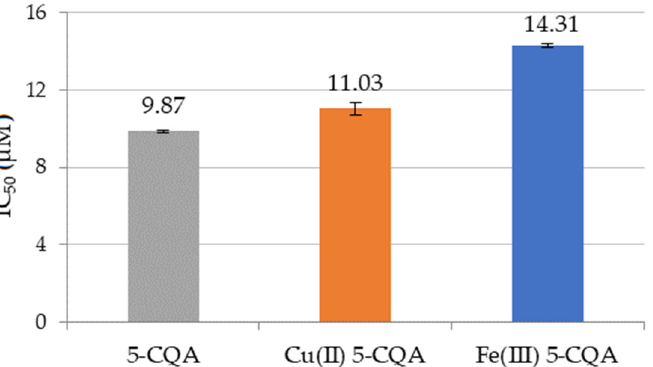
Figure 8. Antioxidant properties of 5-CQA, Cu(II) 5-CQA, and Fe(III) 5-CQA, expressed as the abil- ity to scavenge DPPH • radicals (IC 50 ). Mean values from three independent experiments ± SDs are shown. The same letter near the means indicates no significant difference (Tukey’s test, p < 0.05).